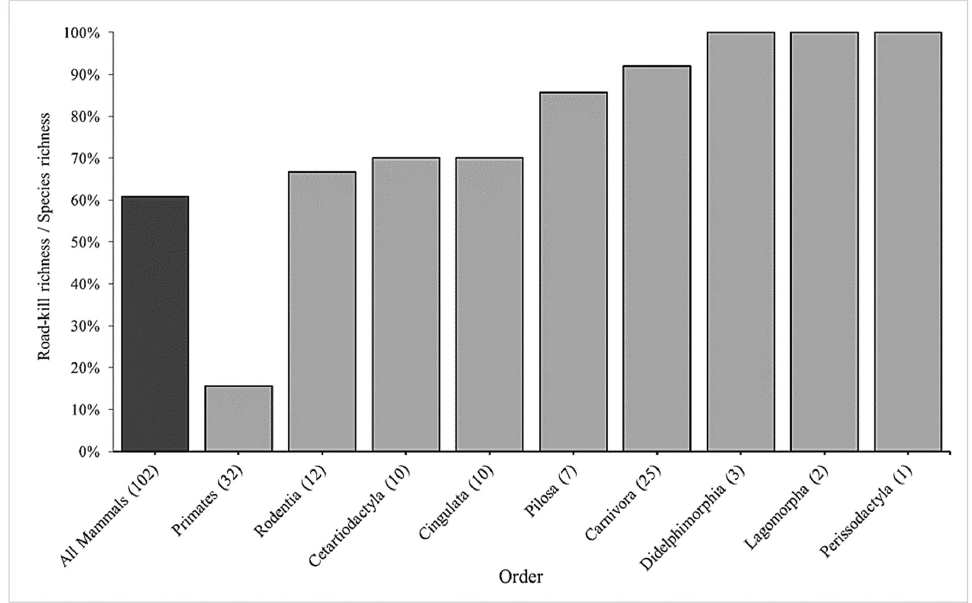
Figure 2. Proportion between road-killed species richness and total species richness of medium–large mammals. In parentheses: total species richness by taxonomic order.